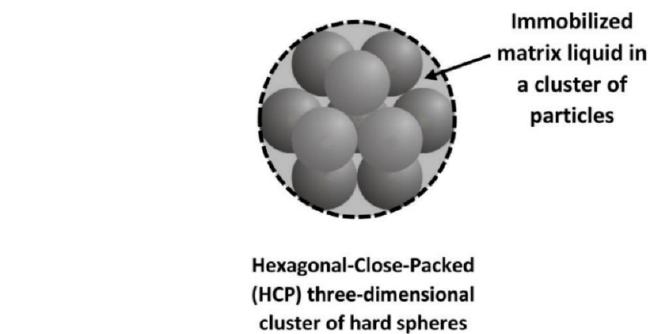
Figure 3. Effective volume of clusters of particles . The shaded area outside the particles represents the immobilized matrix liquid.